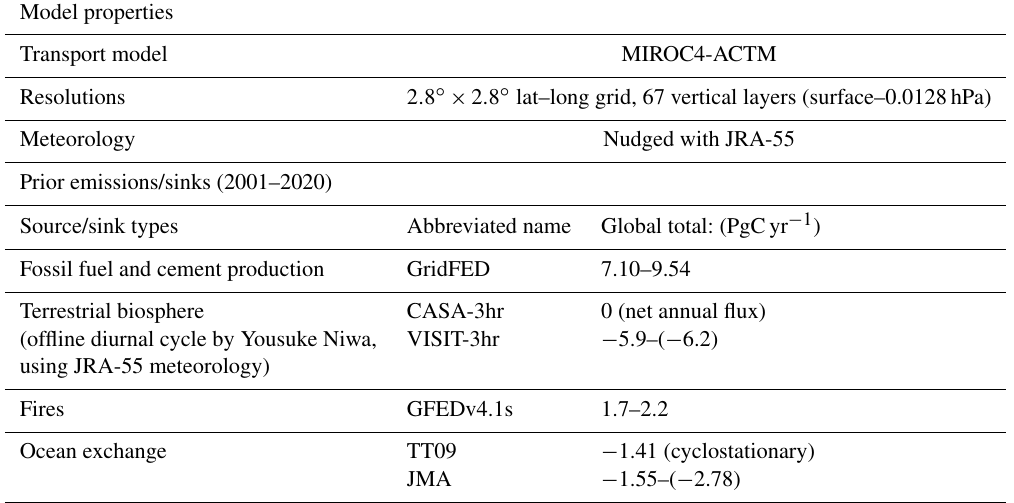
Table 1. Transport model setup and a priori CO 2 emissions used for simulating the atmospheric CO 2 concentrations. The range in prior fluxes (2001–2020) is also given in petagrams of carbon per year (PgCyr − 1 ) for the study